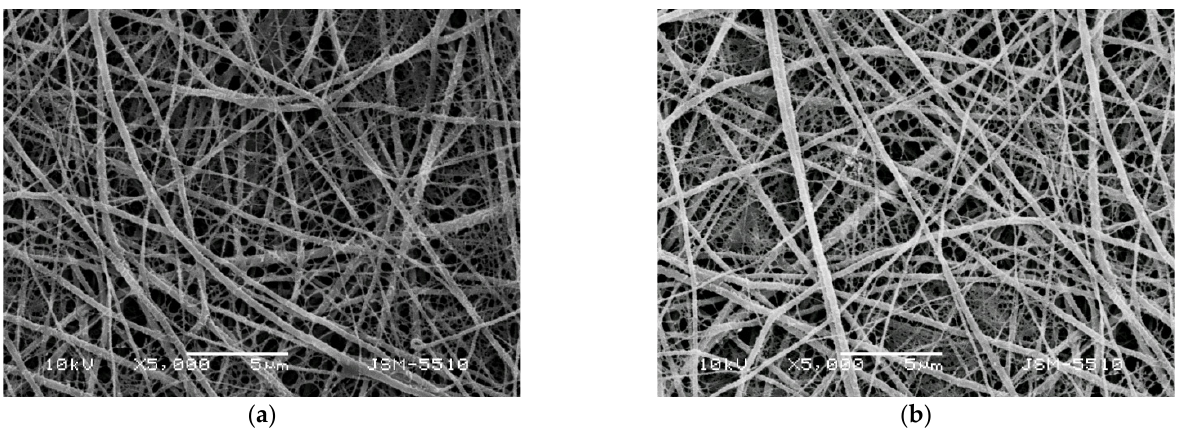
Figure 2. SEM micrographs of electrospun Ch-8Q/PLA (30:70 w / w ) mats after immersion in an ethanol solution of ( a ) CuCl 2 and ( b ) FeCl 3 for 40 min.; magnification ×5000.